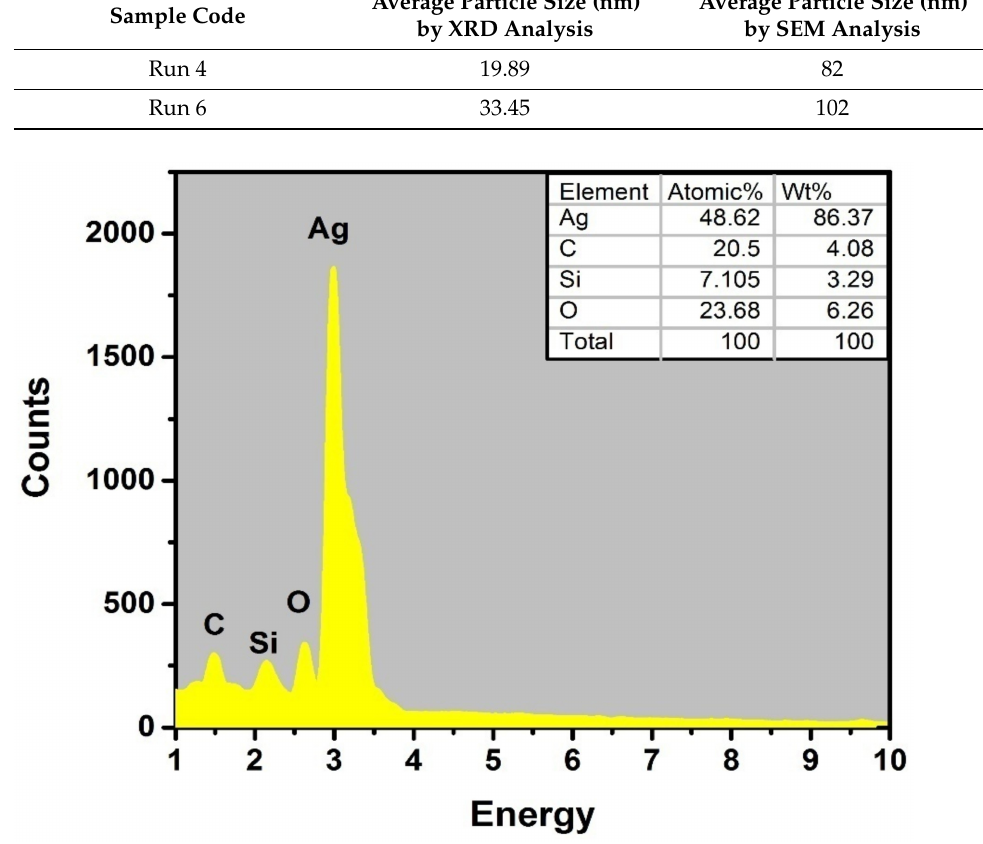
Figure 9. EDX spectra of optimized AgNPs (run